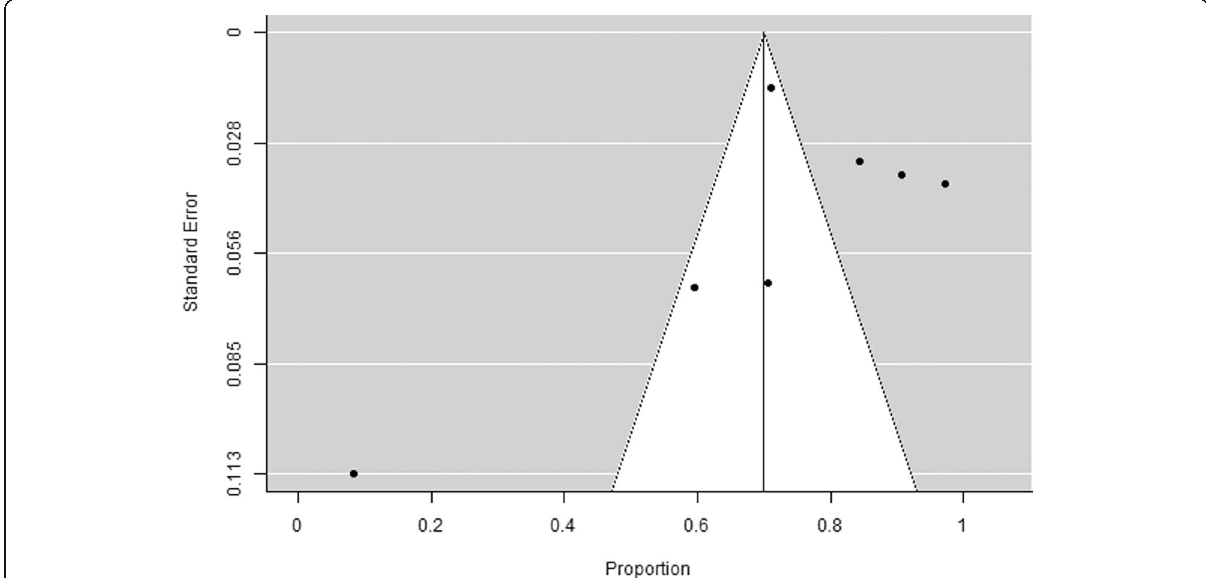
Fig. 4 Funnel plot for sensitivity of the initial CT scan. There is possibility of publication bias (Rosenthal fail-safe number = 7902, rank correlation test for funnel plot asymmetry P value = 0.562, regression test for funnel plot asymmetry P value = 0.002)